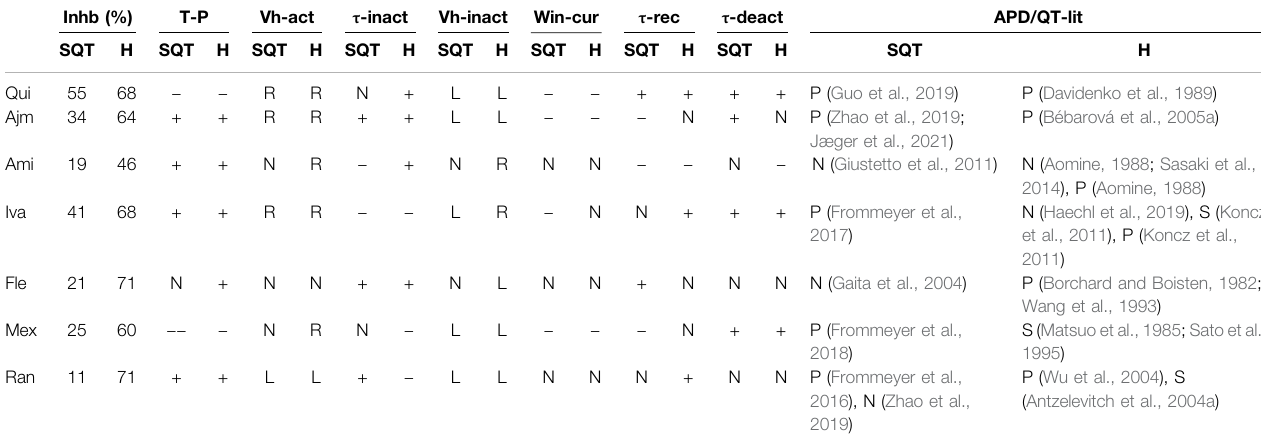
TABLE 1 | Summary of drug effects on I Kr and APD/QT. Inhb